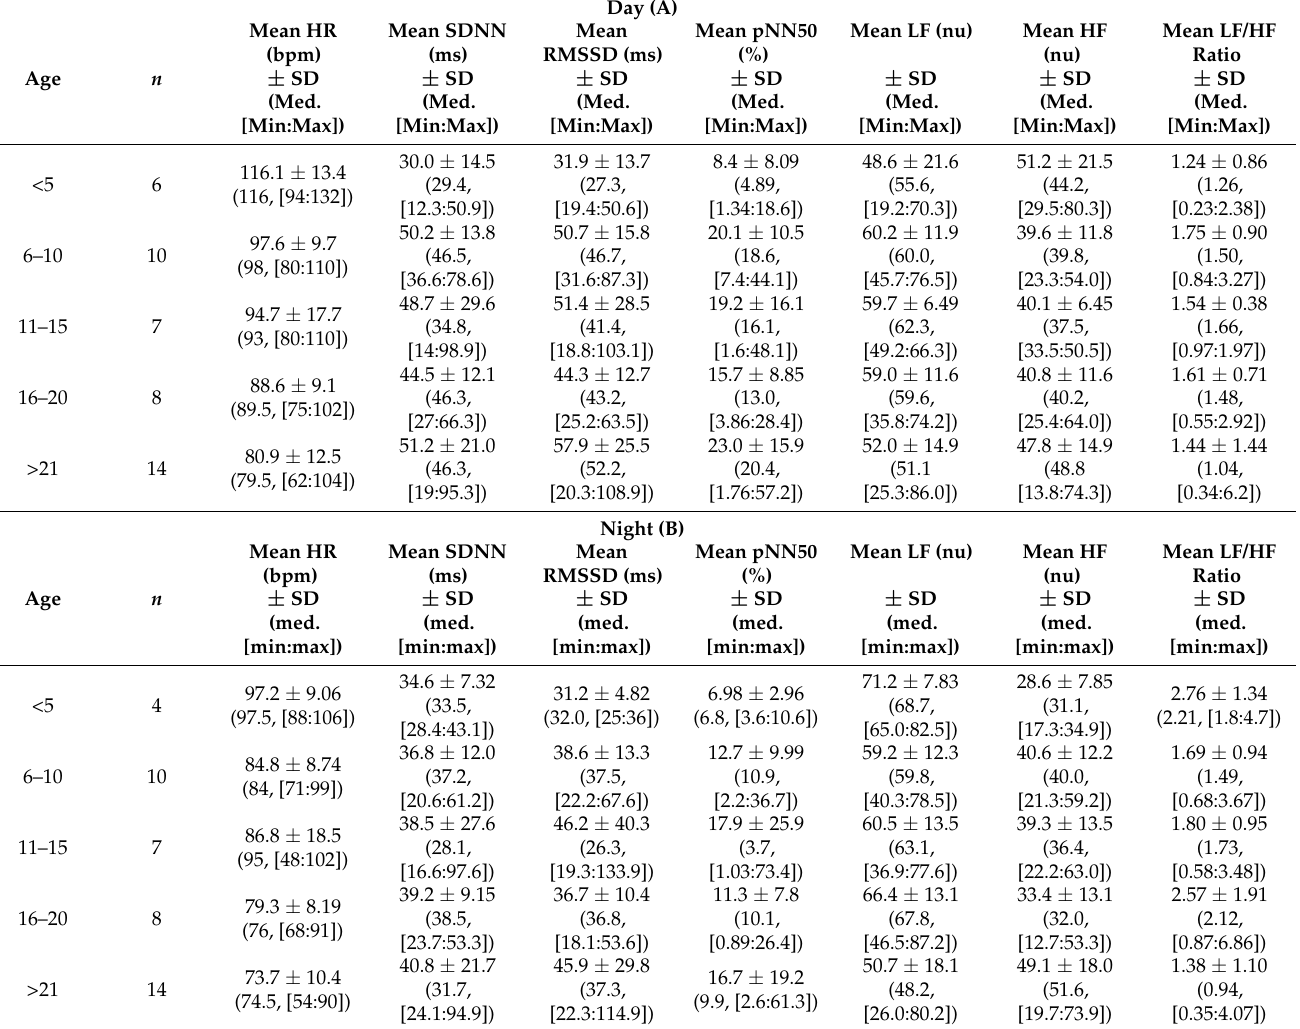
Table 2. Heart rate variability indices according to age